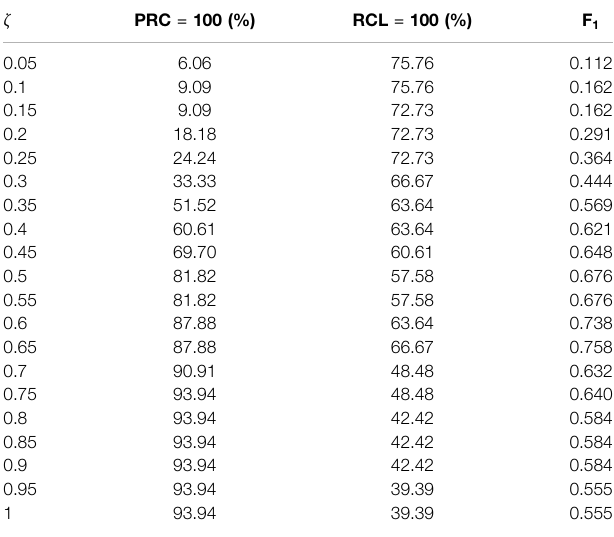
TABLE 1 | The statistic results for different values of weight coef fi